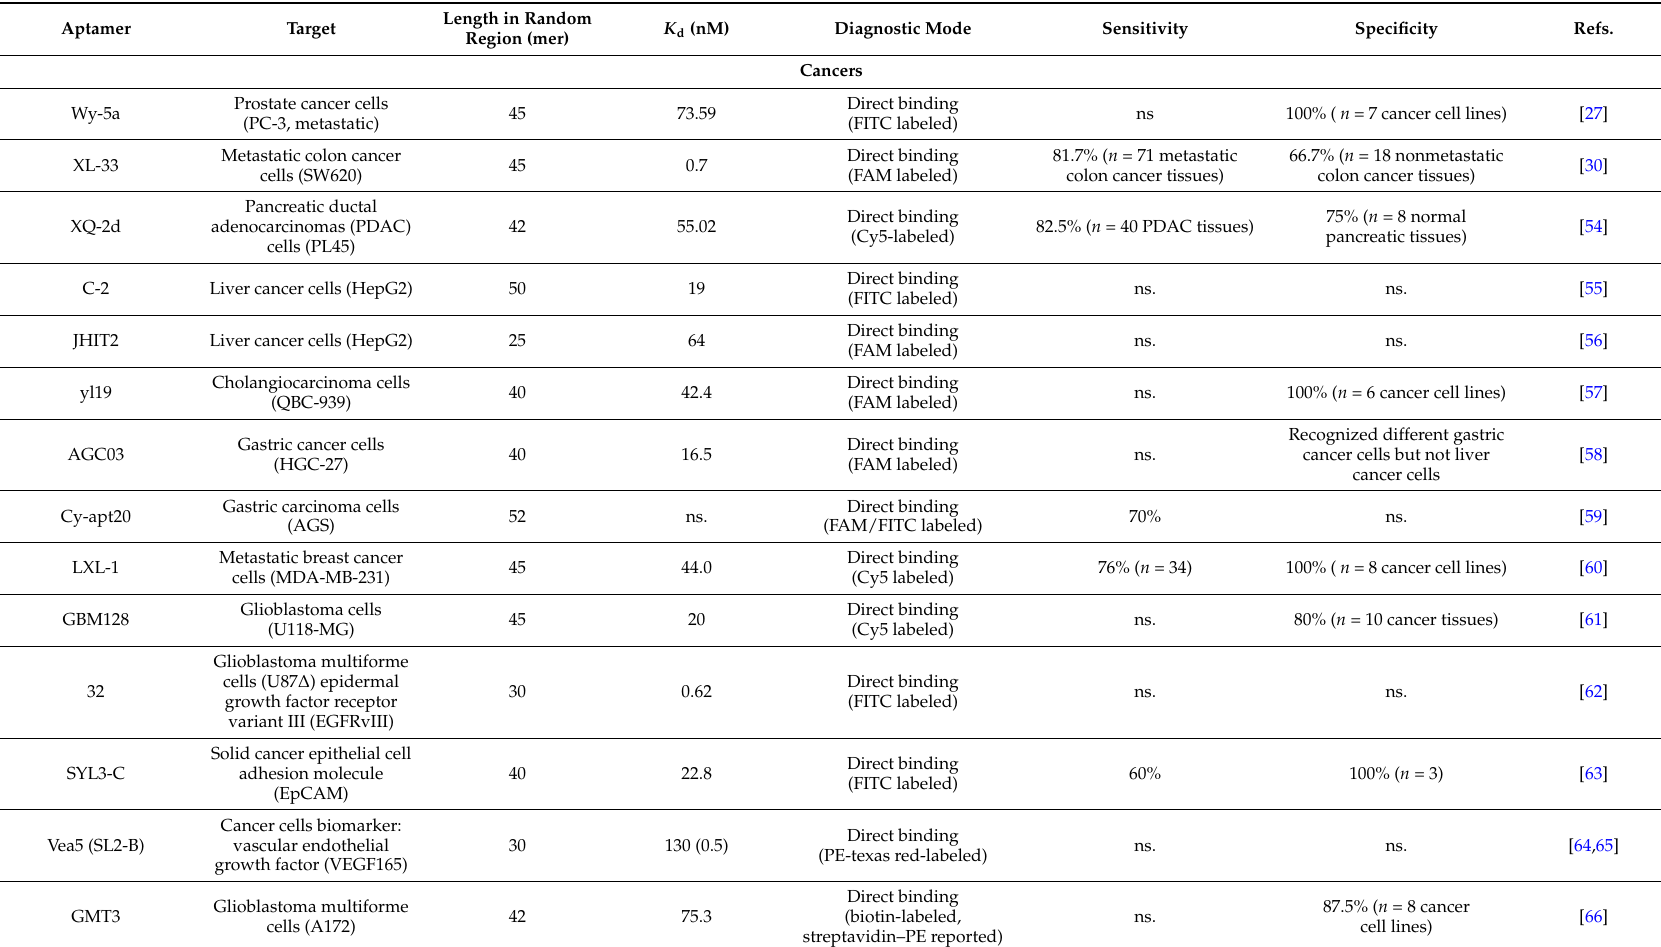
Table 1. Examples of selected DNA aptamers for the diagnosis of human